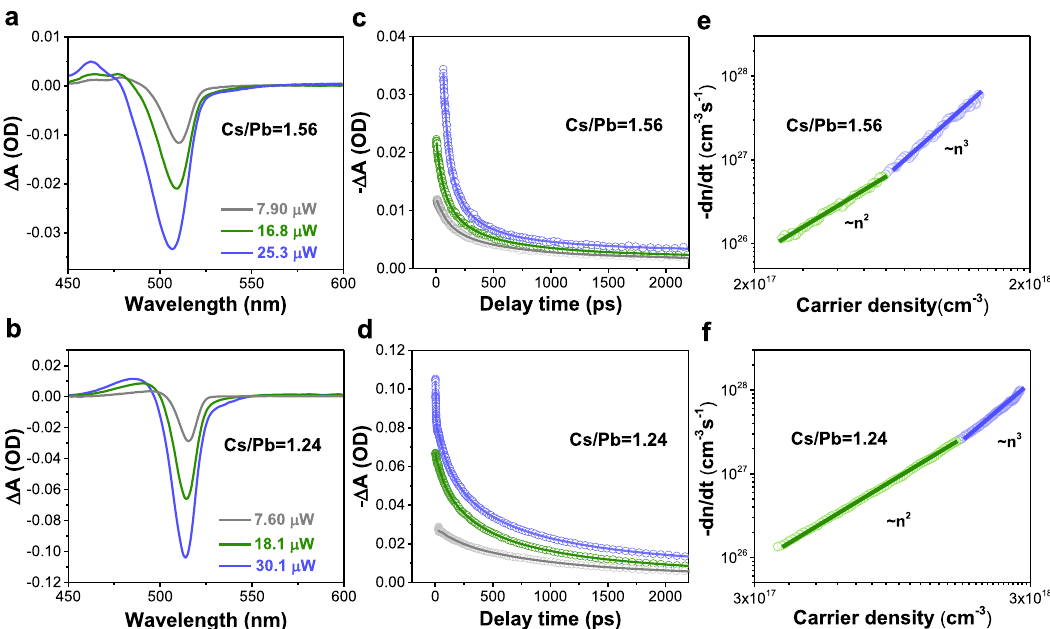
Fig. 2 The recombination dynamics of thermally evaporated Cs-Pb-Br fi lms. a , b The transient absorption spectra of Cs/Pb = 1.56 ( a ) and Cs/Pb = 1.24 ( b ) under 1 ps delay time with various excitation densities. c , d The corresponding dynamic curves of Cs/Pb = 1.56 ( c ) and Cs/Pb = 1.24 ( d ). e , f The relationship between carrier recombination decay rates and carrier density in the cases of Cs/Pb = 1.56 ( e ) and Cs/Pb = 1.24 ( f ). The detailed fi tting method is described in the Supplementary Information.